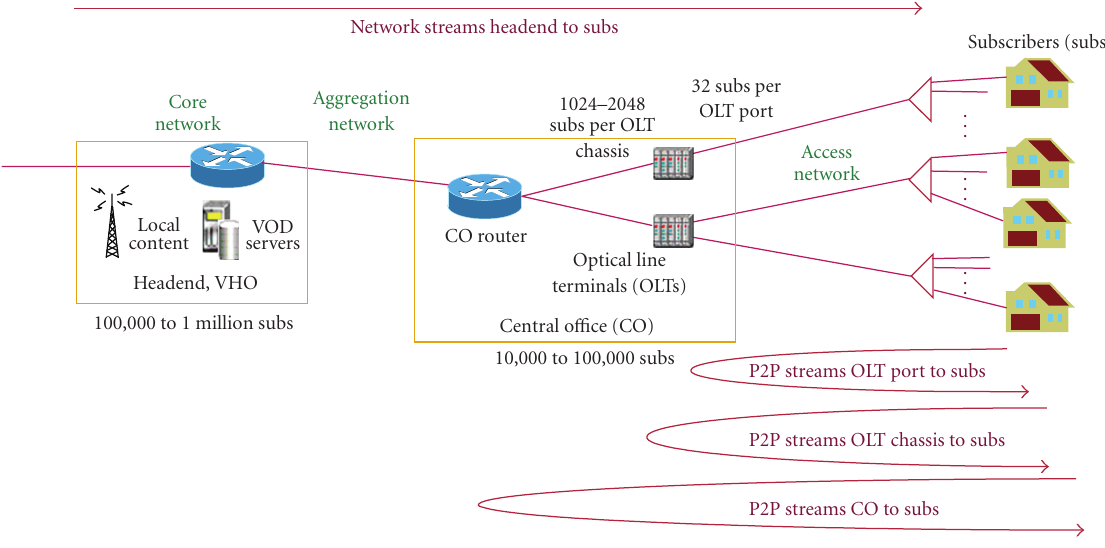
Figure 1: Localized